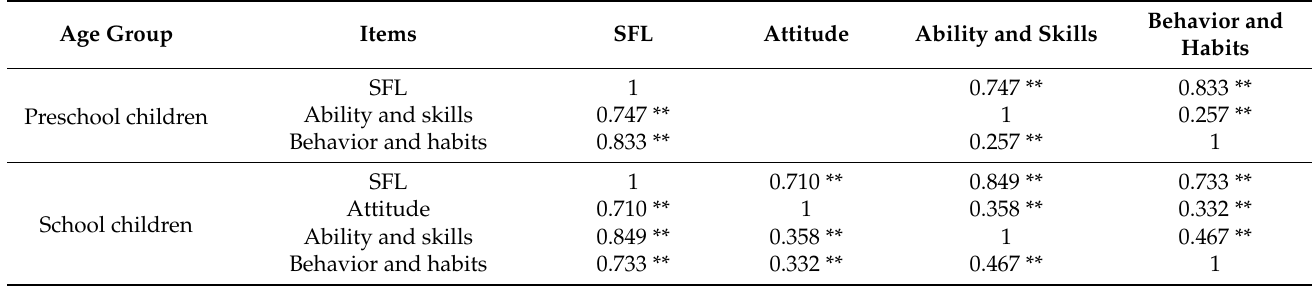
Table 3. Correlation of total scientific fitness literacy score and its sub-dimensions.